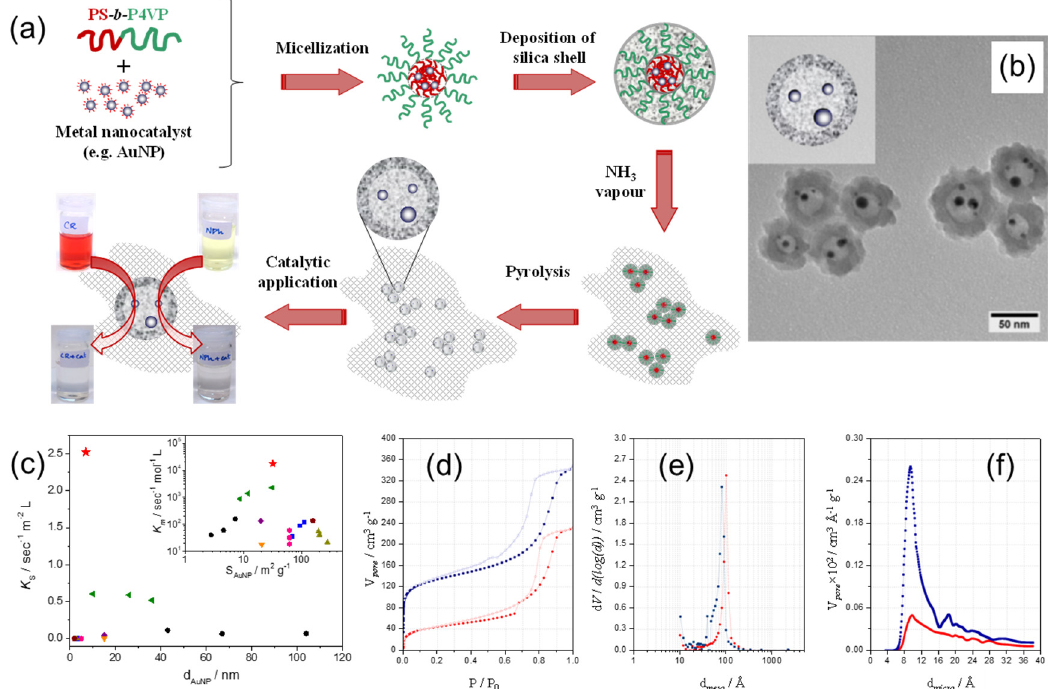
Figure 11. ( a ) Schematics of the preparation of the Au–hollow-SiO 2 –PSS catalyst via the block copolymer template approach; ( b ) TEM image of Au–hollow-SiO 2 yolk-shell particles, prepared using the BCP template method. ( c ) The comparison of normalized reaction rate constants, K s and K m (inset), on the reduction of 4-nitrophenol determined for Au–hollow-SiO 2 –PSS catalyst (red star), with values for analogous catalytic systems reported in literature. ( d ) N 2 adsorption–desorption isotherms of un-pyrolyzed Au–PS– b –P4VP–SiO 2 (red circles) and pyrolyzed Au–hollow-SiO 2 particles (blue squares), as well as corresponding size distributions of ( e ) mesopores and ( f ) micropores. Filled and unfilled symbols correspond to adsorption and desorption processes, respectively. Adapted from [32].